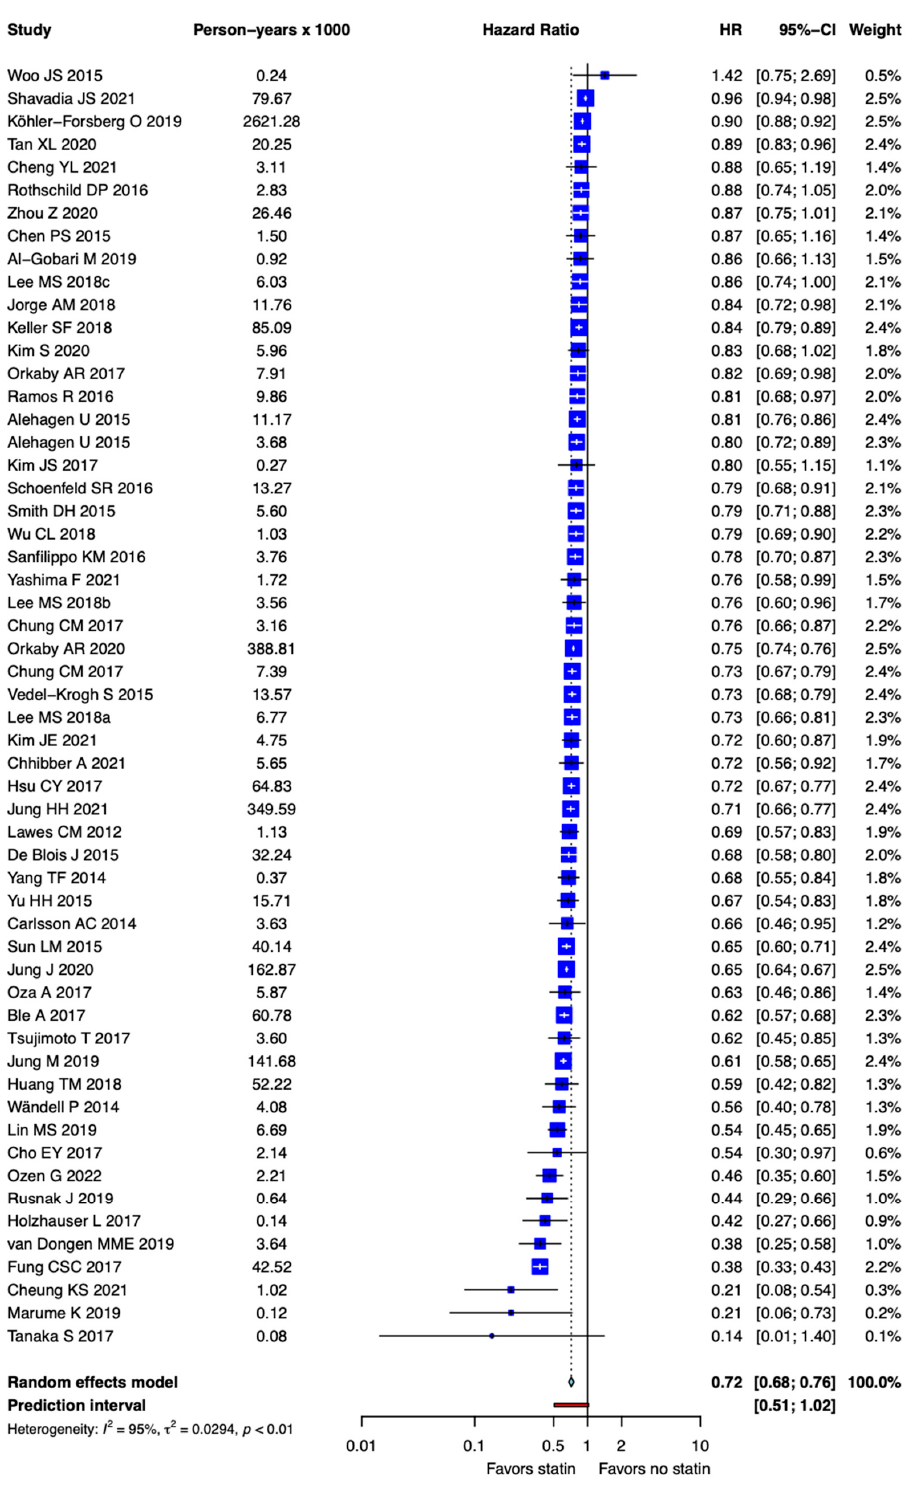
Figure 2. Forest plot showing the association between statin use and all-cause mortality.